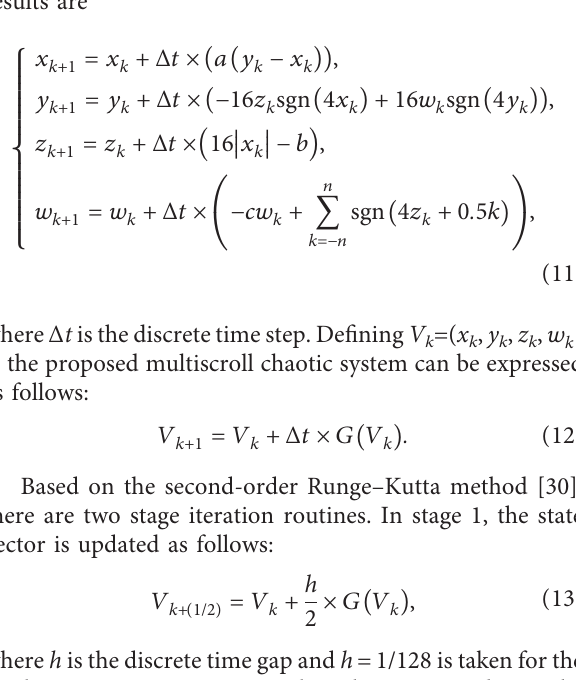
Figure 9: The basin of attraction of the proposed chaotic system under mode 1: M ( − , +) under a � 112, b � 2.4, c � 16, x � w 0